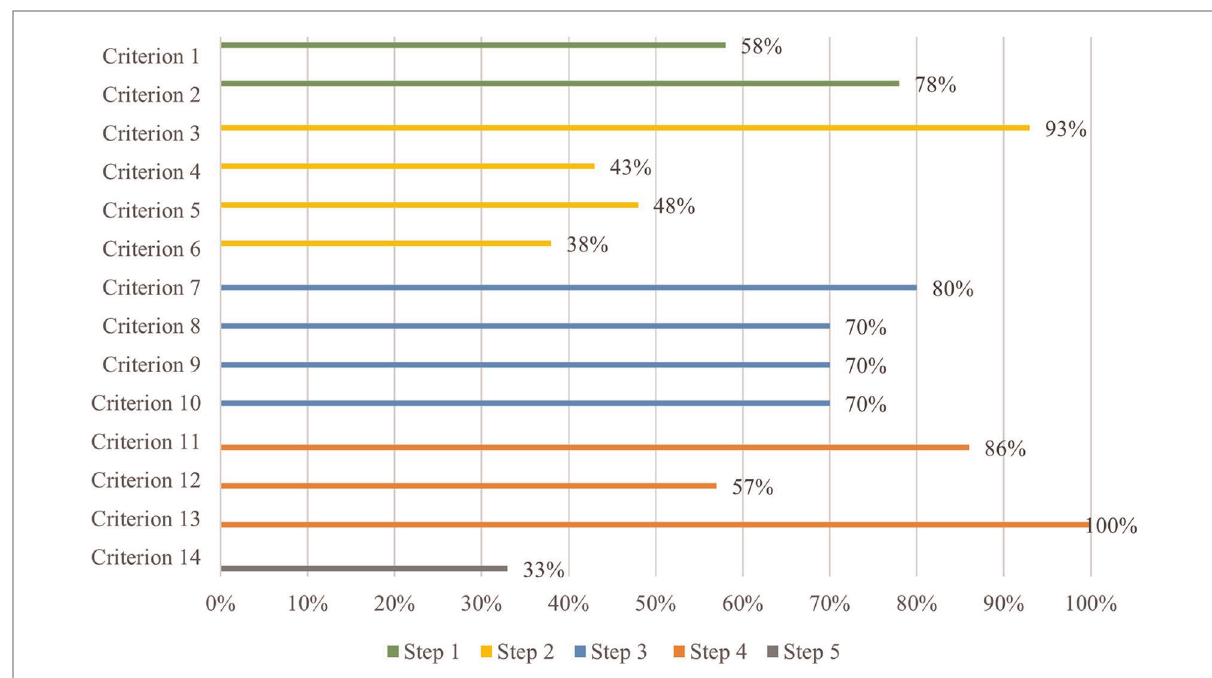
FIGURE 3 Assessment of apps using the APA framework — percentage of apps within each of the 5 steps meeting each criterion item. (Note. Step 1= Accessibility, Step 2=Security & Privacy, Step 3=Evidence & Clinical Base, Step 4=User Engagement, Step